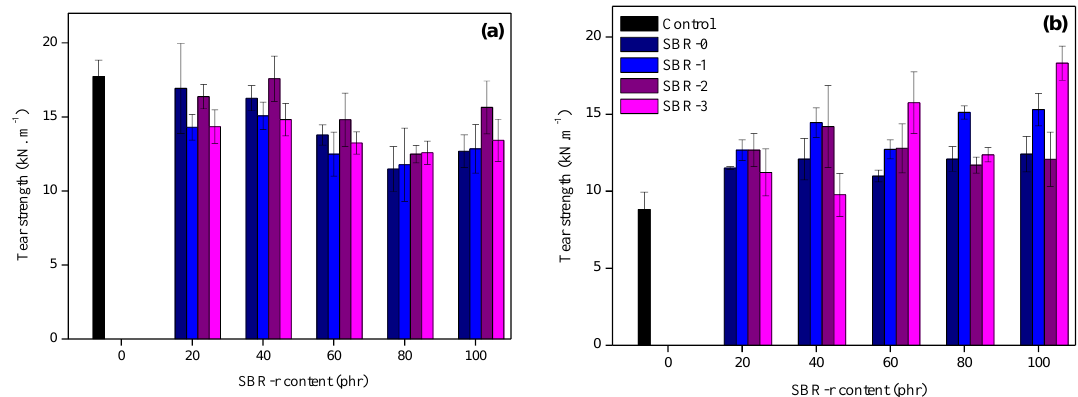
Figure 3. Tear strength results of SBR-r composites, before ( a ) and after ( b ) accelerated aging in an air oven.